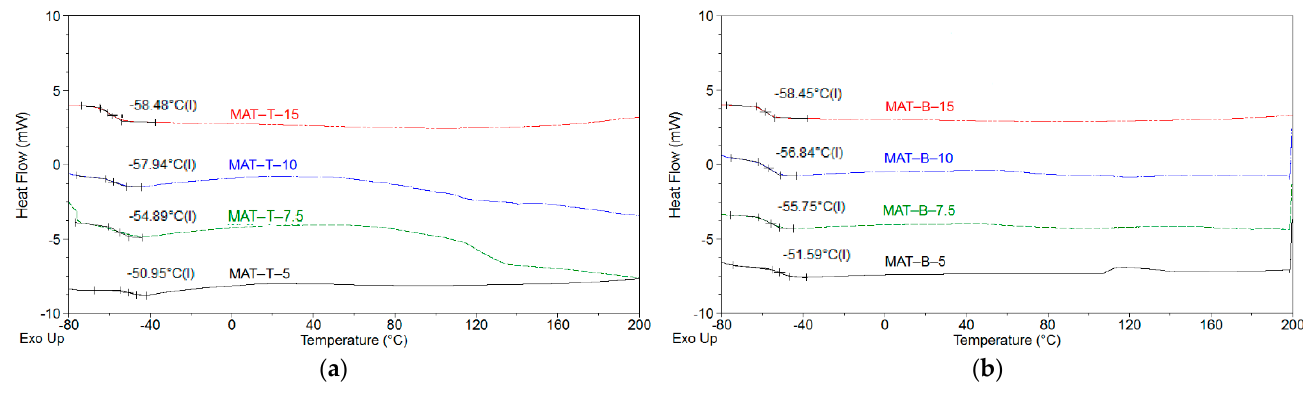
Figure 3. DSC thermographs for MAT-T ( a ) and MAT-B solutions ( b ).